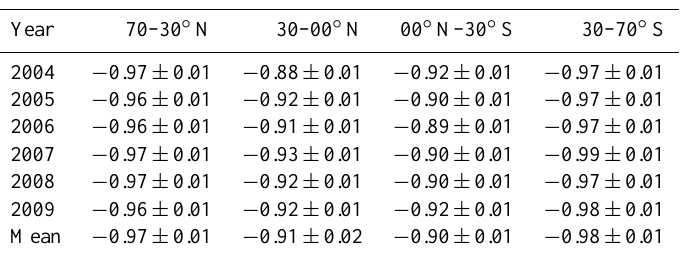
Table 5. The slopes of the correlation between fluorine source species (CF 4 , CFC-12, CFC-11, HCFC-22, SF 6 , CFC-113, CFC-114, CFC- 115, H-1211, H-1301, HCFC-141b, HCFC-142b, HFC-23, HFC-134a and HFC-152a) and fluorine reservoir species (HF, COF 2 and COClF). Once more, the error given here is the 1- σ error of a least-squares fit.